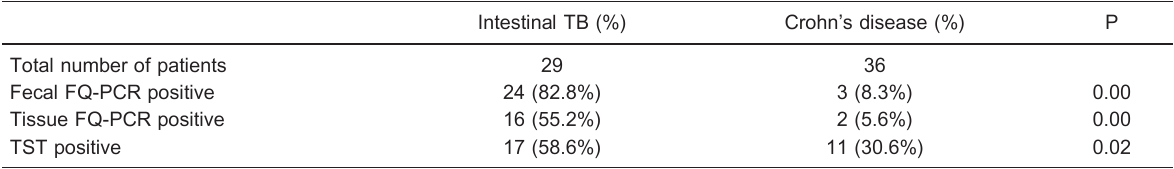
Table 2. Results of fecal FQ-PCR, tissue FQ-PCR and TST for Mycobacterium tuberculosis in the patient groups.